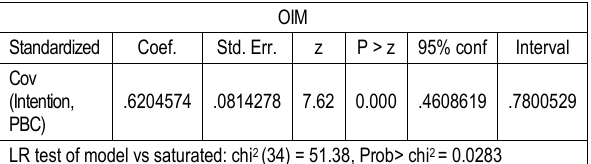
Table 6. Covariance between perceived